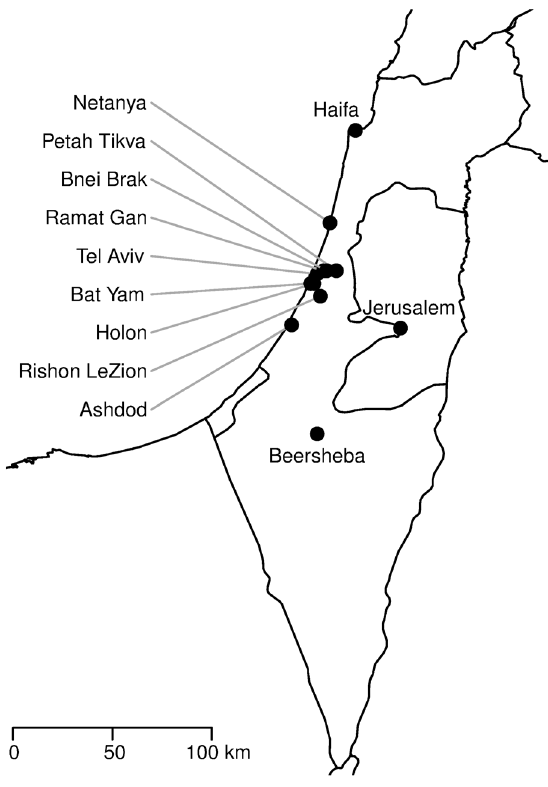
Figure 2. A map of Israel and the 12 cities analysed in this